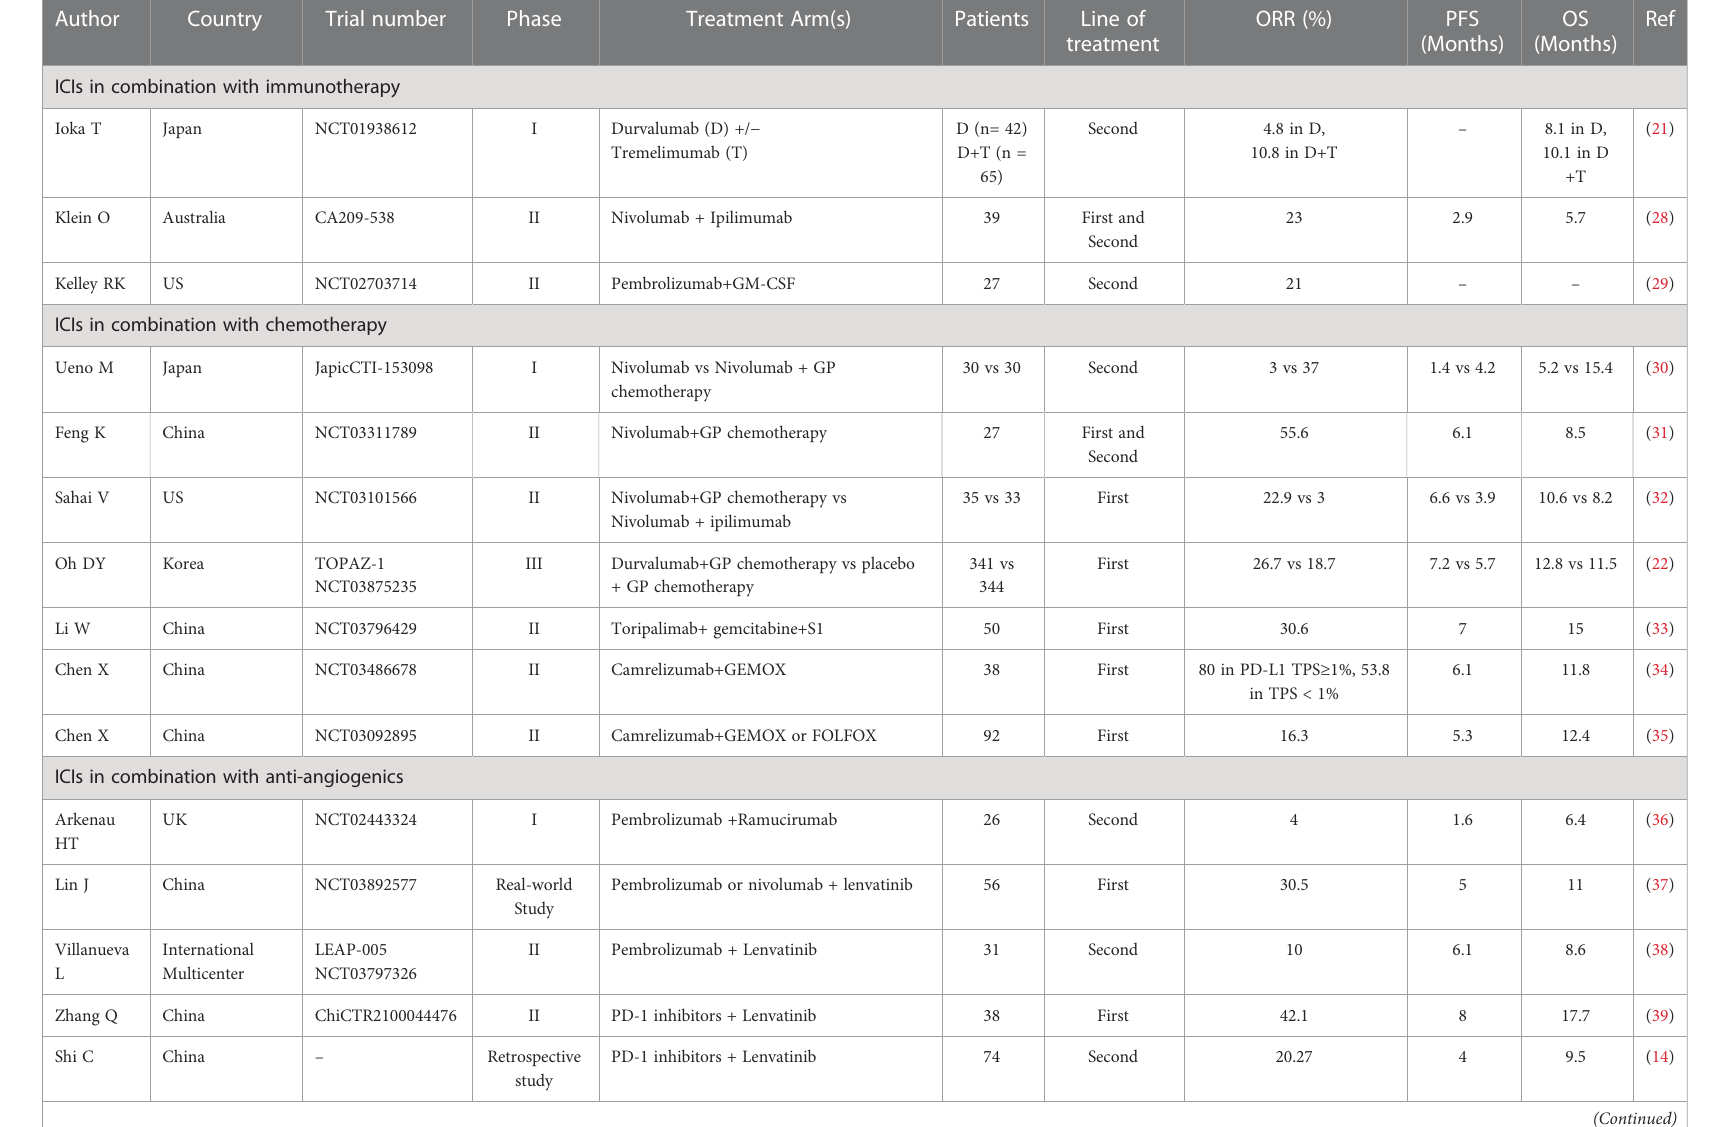
TABLE 1 Selected published trials on the combination of ICIs with immunotherapy, chemotherapy, anti-angiogenics or local therapy in advanced biliary tract cancer.